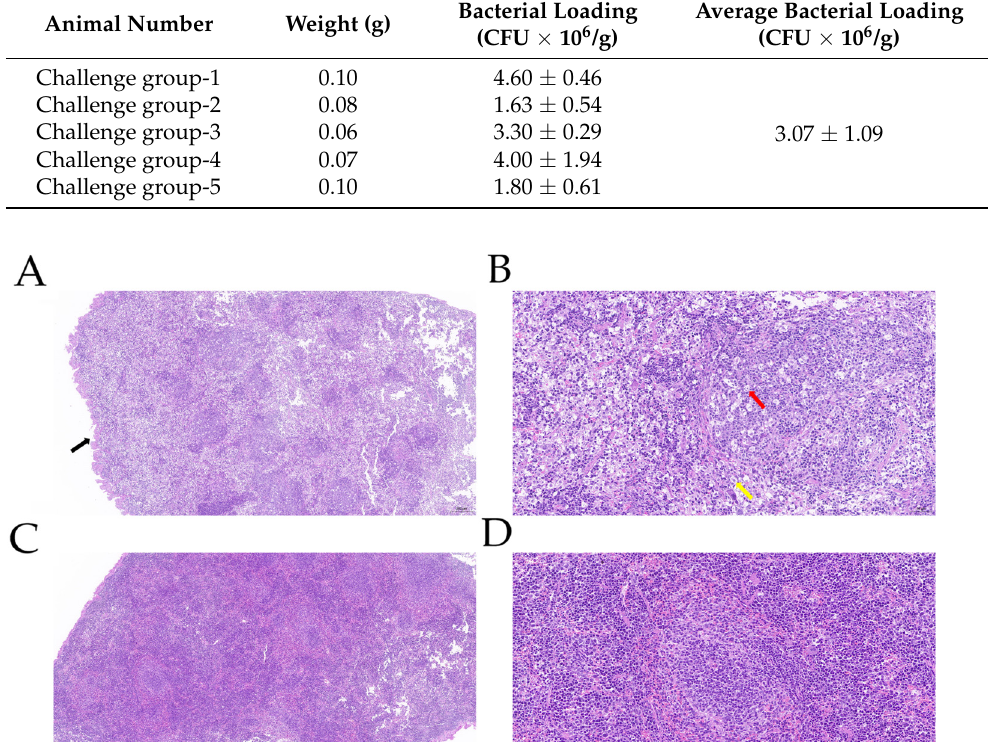
Table 2. Bacterial loads of mice spleens in challenge group.